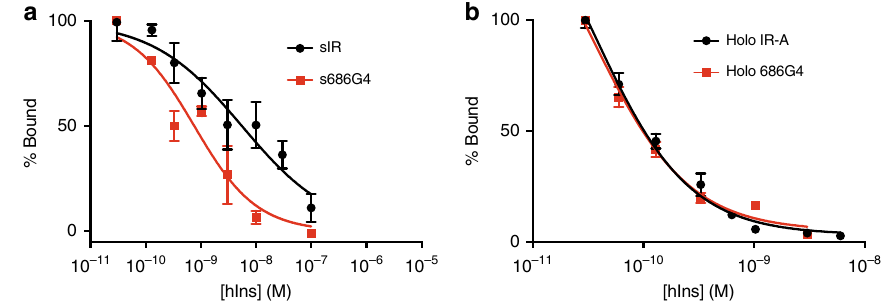
Fig. 5 Insulin competition-binding assays for 686G4 IR mutants. a Insulin competition-binding assay of sIR (IC 50 = 5.6 ± 1.7 nM; n = 4 technical replicates per concentration point) and s686G4 (IC 50 = 0.76 ± 0.16 nM; n = 4 technical replicates per concentration point). The IC 50 values differ at the 95% level of con fi dence based on an F test ( P < 0.0001; no. of degrees of freedom = 54; two individual measurements of sIR af fi nity were judged as systematically in error and omitted from the analysis). b Insulin competition-binding assay of hIR-A (IC 50 = 52 ± 10 pM; n = 4 technical replicates per data point) and holo 686G4 (IC 50 = 30 ± 6 pM; n = 10 technical replicates per data point). The IC 50 values are the same at the 95% level of con fi dence based on an F test ( P = 0.084; no. of degrees of freedom = 86). In both ( a ) and ( b ), error bars re fl ect s.e.m. and are not shown when smaller than marker size